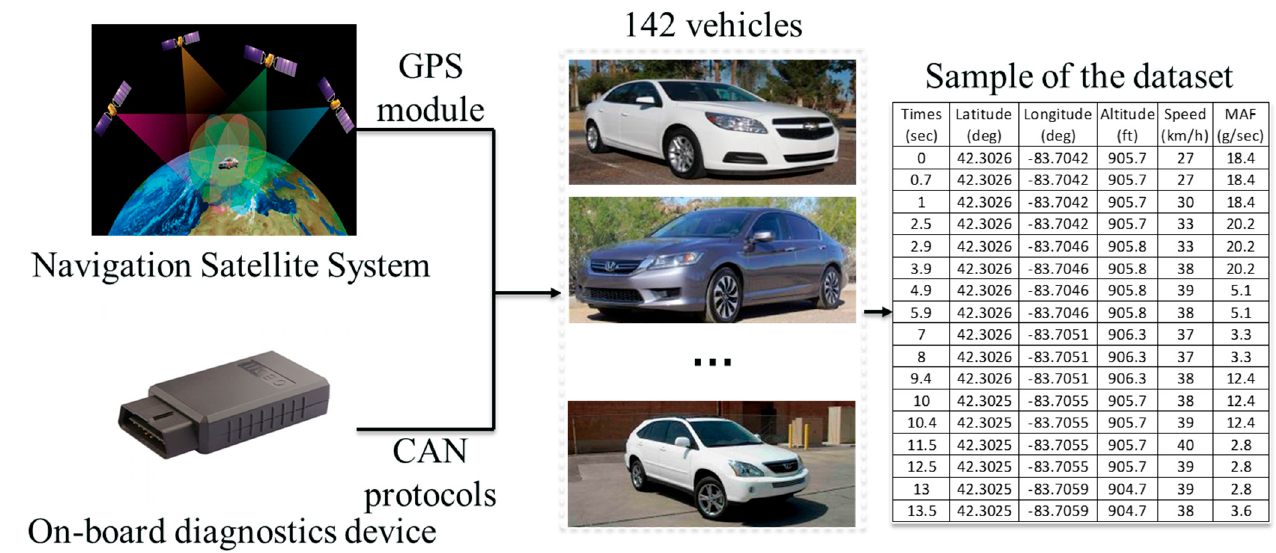
Figure 2. Field data collection process.